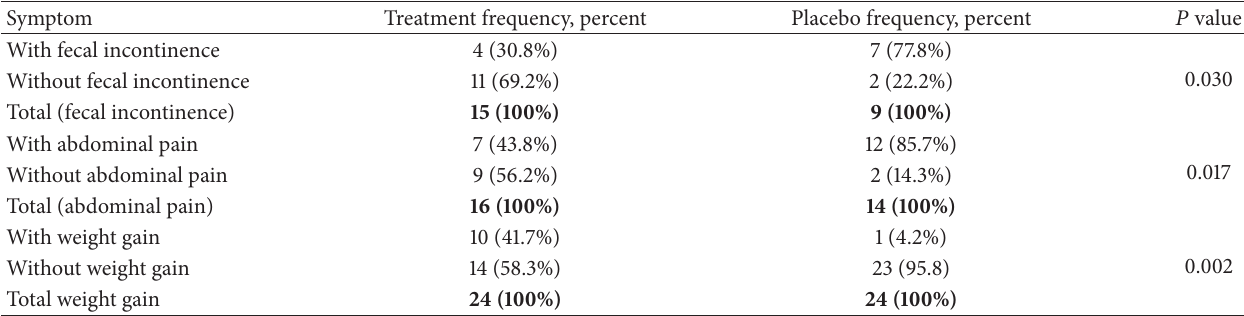
Table 3: Symptom changes at the end of the 1st